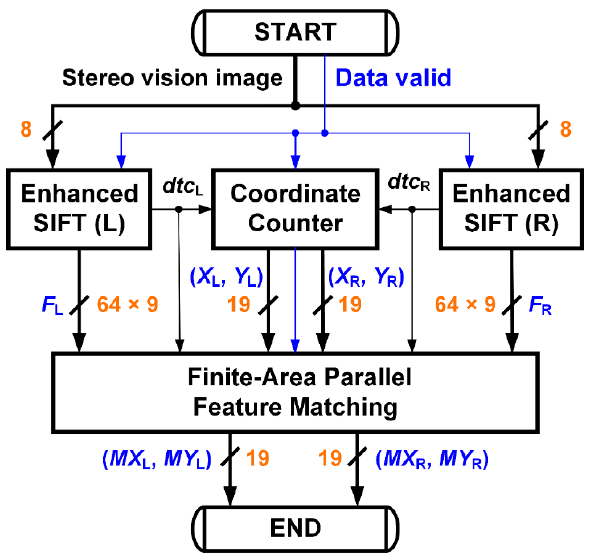
Figure 16. Building blocks of the proposed E-SIFT and FAP feature matching for stereo vision.